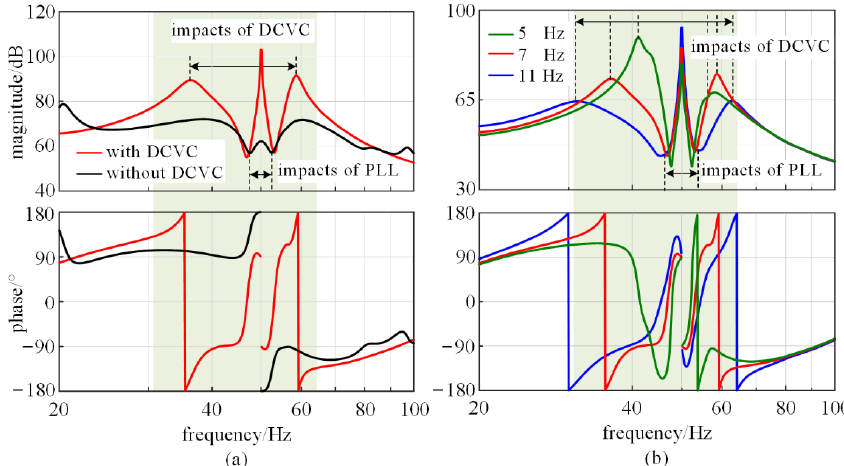
Figure 4. Impacts of DC voltage controller on MMC-HVDC impedance characteristic (DCVC stands for DC voltage control). ( a ) comparison of MMC-HVDC impedance characteristic w/wo DC voltage control. ( b ) impacts of DC voltage control parameters on MMC-HVDC impedance characteristic.